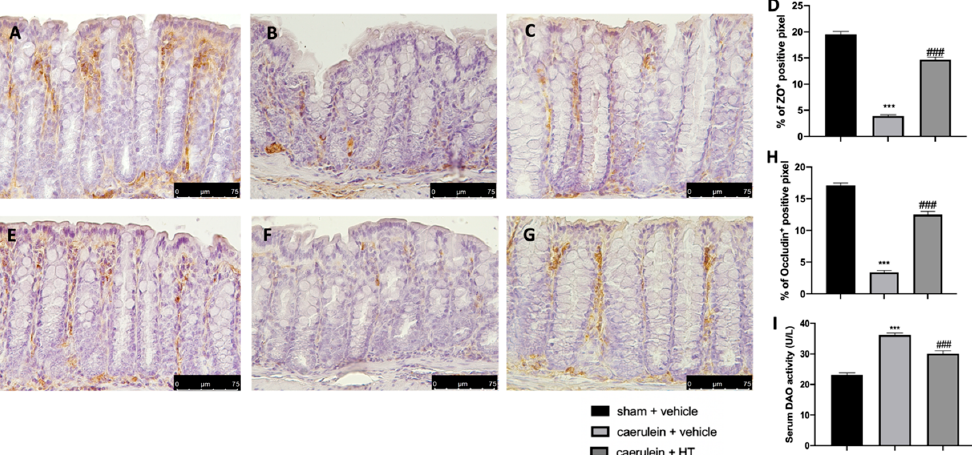
Figure 8. Hydroxytyrosol (HT) effect on zonula occludens (ZO) and occludin expression in pancreatic tissue: immunohistochemical analysis of ZO of sham + vehicle ( A ), caerulein + vehicle ( B ) and caerulein + HT(5mg / kg)( C )administration. GraphicalquantificationofZOexpression(D).Immunohistochemical analysis of occludin of sham + vehicle ( E ), caerulein + vehicle ( F ) and caerulein + HT (5 mg / kg) ( G ) administration. Graphical quantification occludin expression (H). For the analyses, n = 5 animals from each group were employed. A p -value < 0.05 was considered significant. *** p < 0.001 vs. sham + vehicle, ### p < 0.001 vs. caerulein + vehicle.